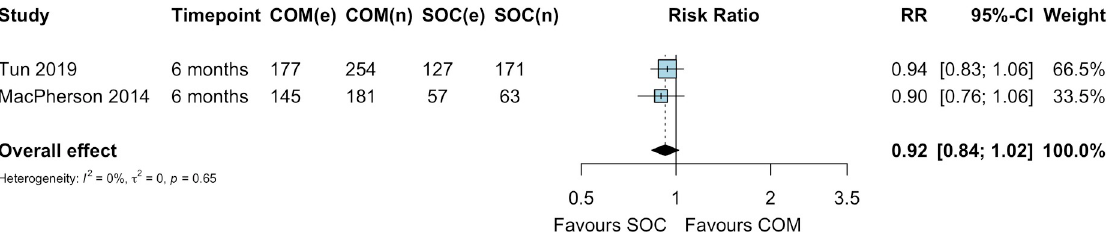
Fig 7. ART adherence among ART initiators at 6 months. COM, community ART initiation; e, number of events; n, number of participants; RR, risk ratio; SOC, standard of care. MacPherson 2014 reflects cluster-adjusted estimates based on the Cochrane method of adjusting for the design effect.